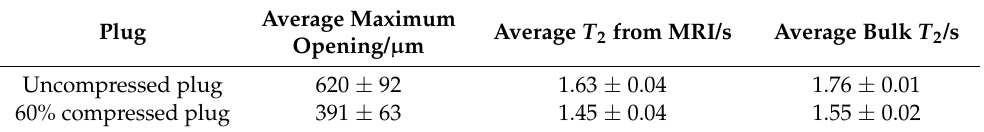
Table 2. Average maximum opening from µCT, average MR T 2 relaxation time from T 2 relaxation MR map and average bulk T 2 relaxation time determined from a mono-exponential fit to the CPMG data. The variability in average maximum opening and T 2 relaxation time from MR maps, comes from the standard deviation of values across the sample.